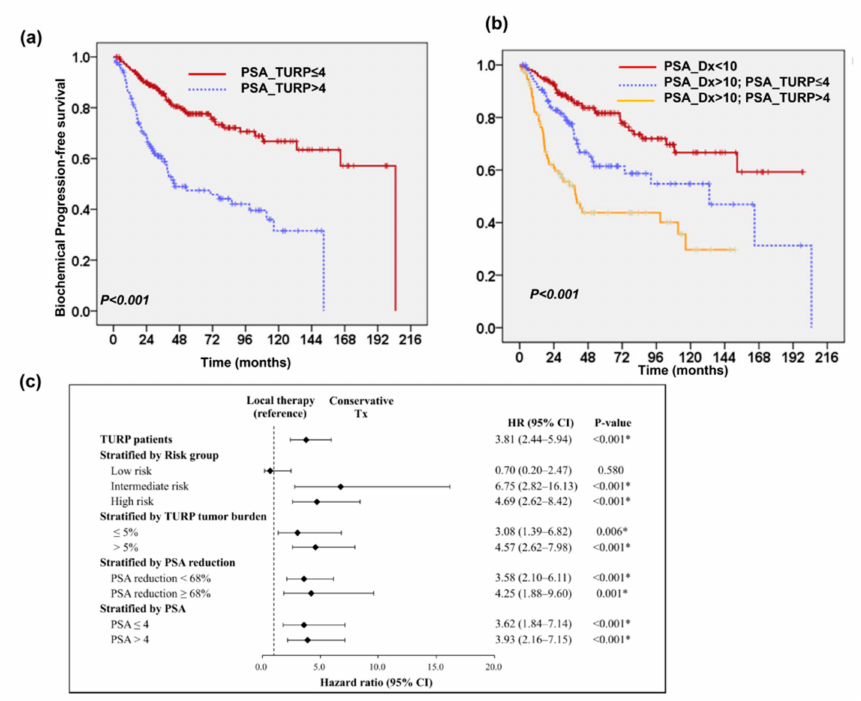
Figure 5. Predictive role of PSA level after TURP. Kaplan-Meier PFS survival curves of 362 patients stratified by PSA levels after TURP ≤ 4 ng/mL (versus > 4 ng/mL) ( a ). Survival difference in patients according to PSA levels at diagnosis combined with that after TURP ( b ). Additionally, local therapy significantly improved PFS when patients were stratified by the pathologic finding of TURP and changes in PSA ( c ). *, Statistical significance.